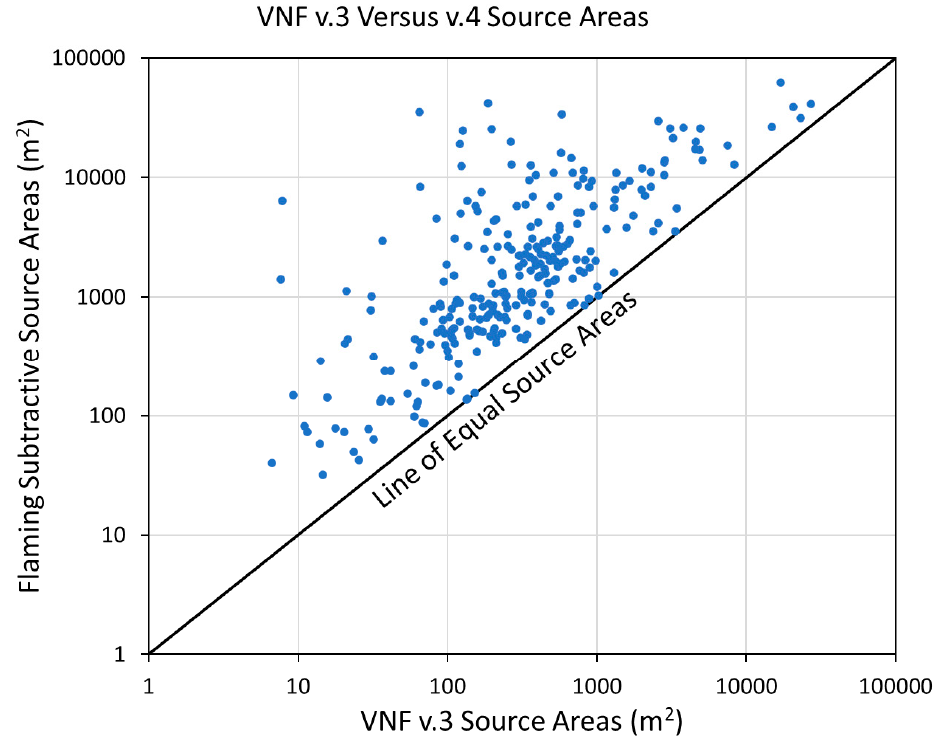
Figure 21. VNF v.3 versus flaming subtractive source areas for the primary and secondary emitters having valid fits.